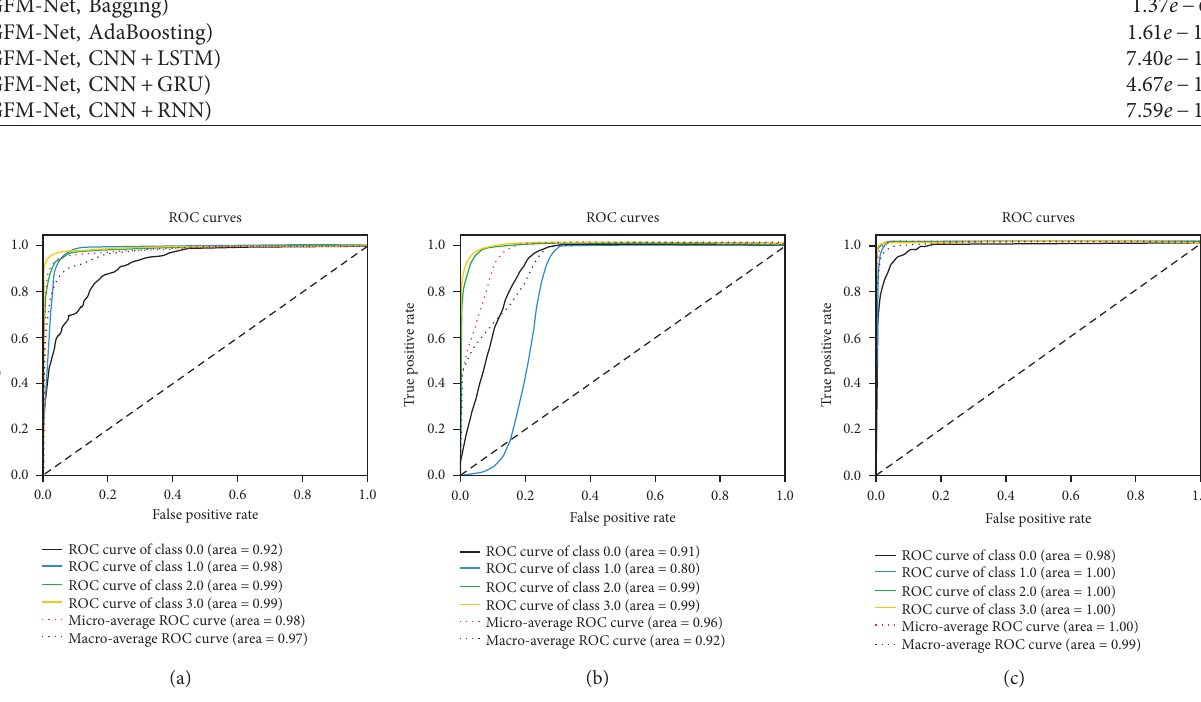
ROC curve of class 0.0 (area = 0.92) ROC curve of class 1.0 (area = 0.98) ROC curve of class 2.0 (area = 0.99) ROC curve of class 3.0 (area = 0.99) Micro-average ROC curve (area = 0.98) Macro-average ROC curve (area = Figure 12: ROC curve performance in three models: Bagging (a), AdaBoosting (b), and GFM-Net. (c) The treadmill speed is set to